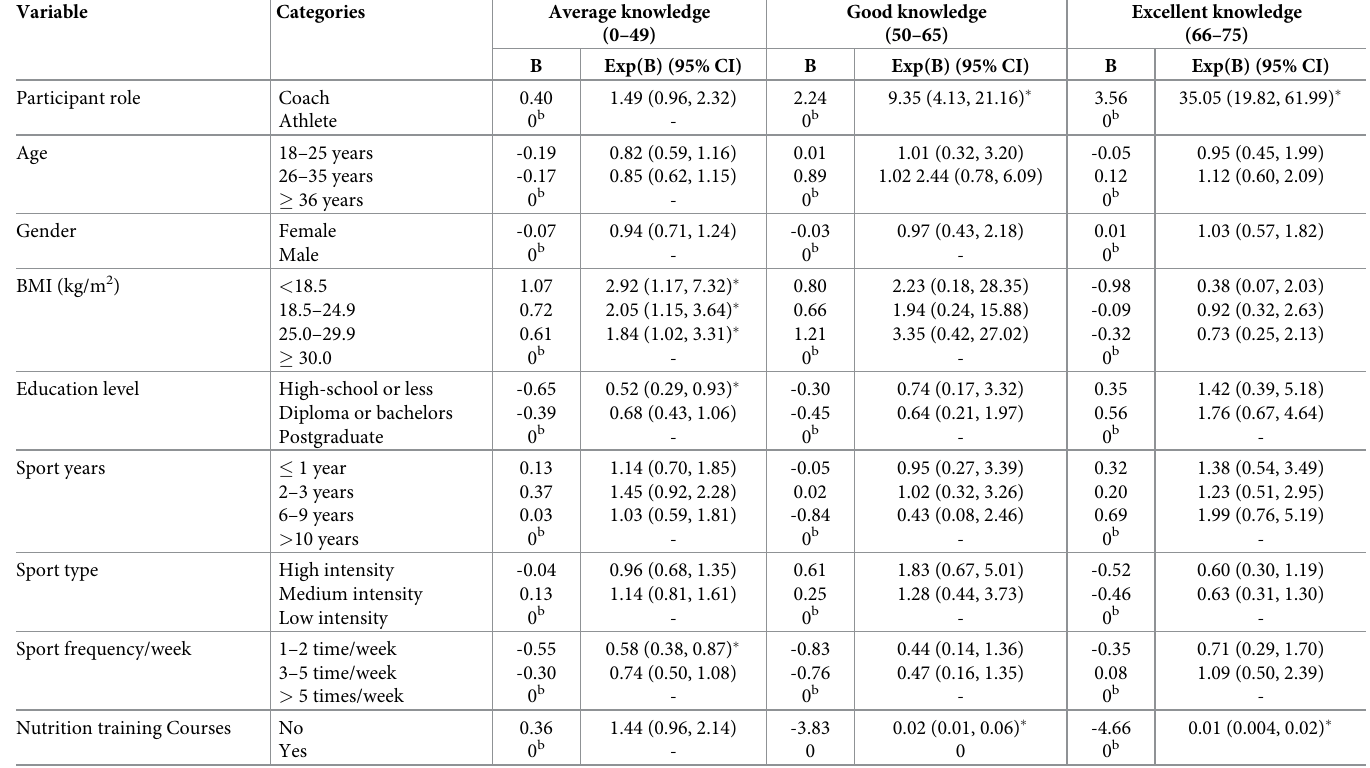
Table 4. Multivariate logistic regression of the ability of participants sociodemographic and lifestyle characteristics to predict knowledge categories obtained on the Abridged Nutrition Knowledge Questionnaire